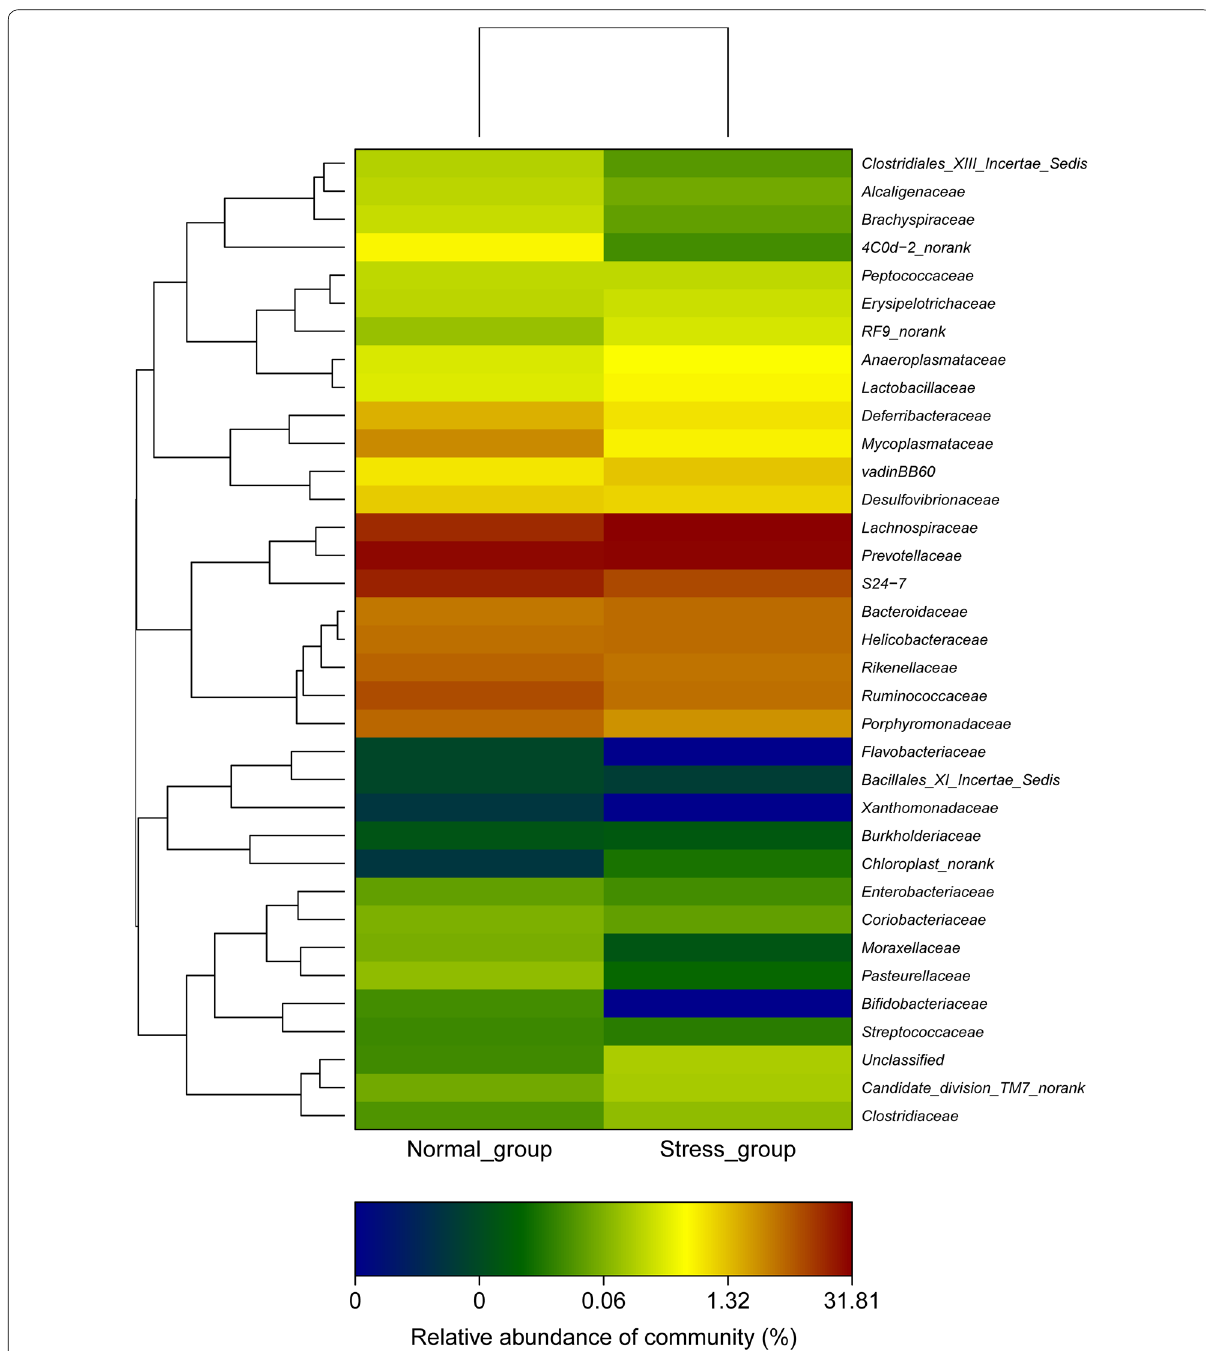
Fig. 5 Heat map diagram at the family